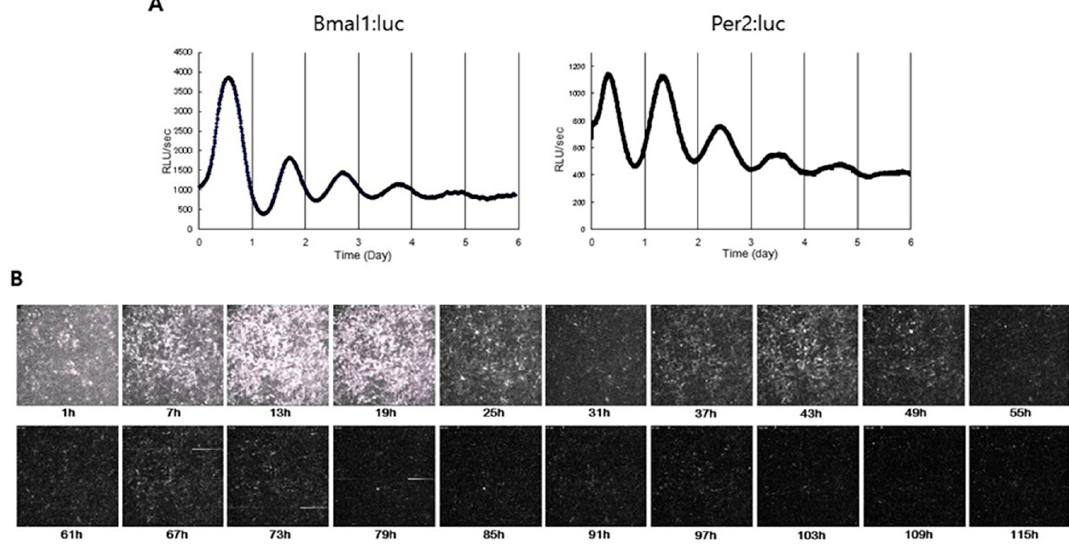
Figure 2. Bioluminescence imaging of circadian rhythms in chondrogenic cells. ( A ) The bioluminescence monitoring of ATDC5 cells transfected with the Bmal1-pEluc plasmid or the Per2-pEluc plasmid, shows circadian rhythms. ( B ) The single-cell imaging of ATDC5 cells transfected with the Bmal1-pEluc plasmid shows circadian rhythms in individual cells.